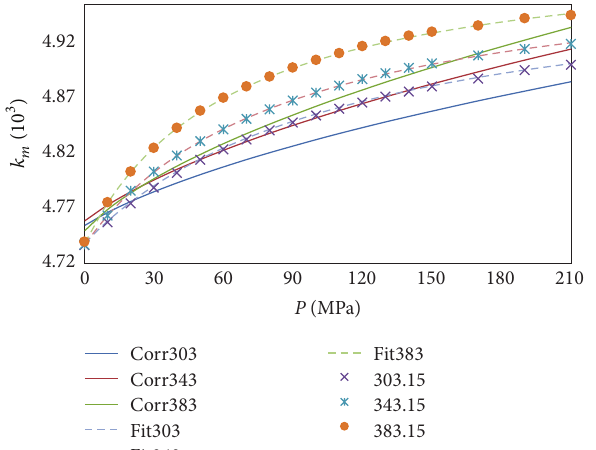
Figure 9: Molecular compressibility’s values calculated from five formulas for methyl caprate at atmospheric pressure.